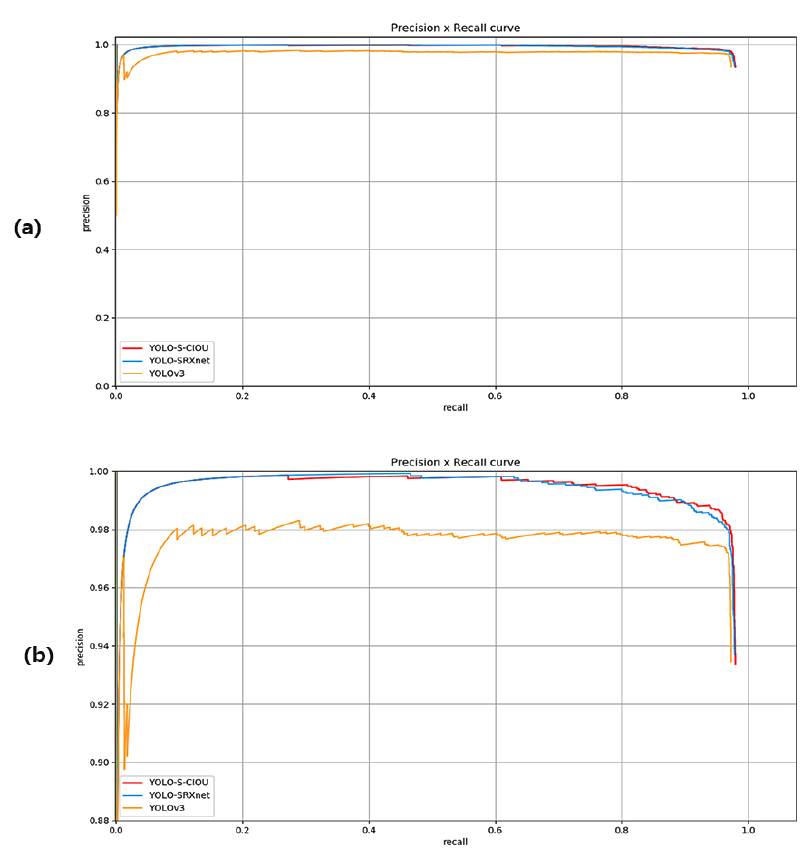
Figure 10. Three networks’ precision–recall curves (PRC). ( b ) is a PRC enlarged from ( a ) to better reflect the relationship of the three curves .